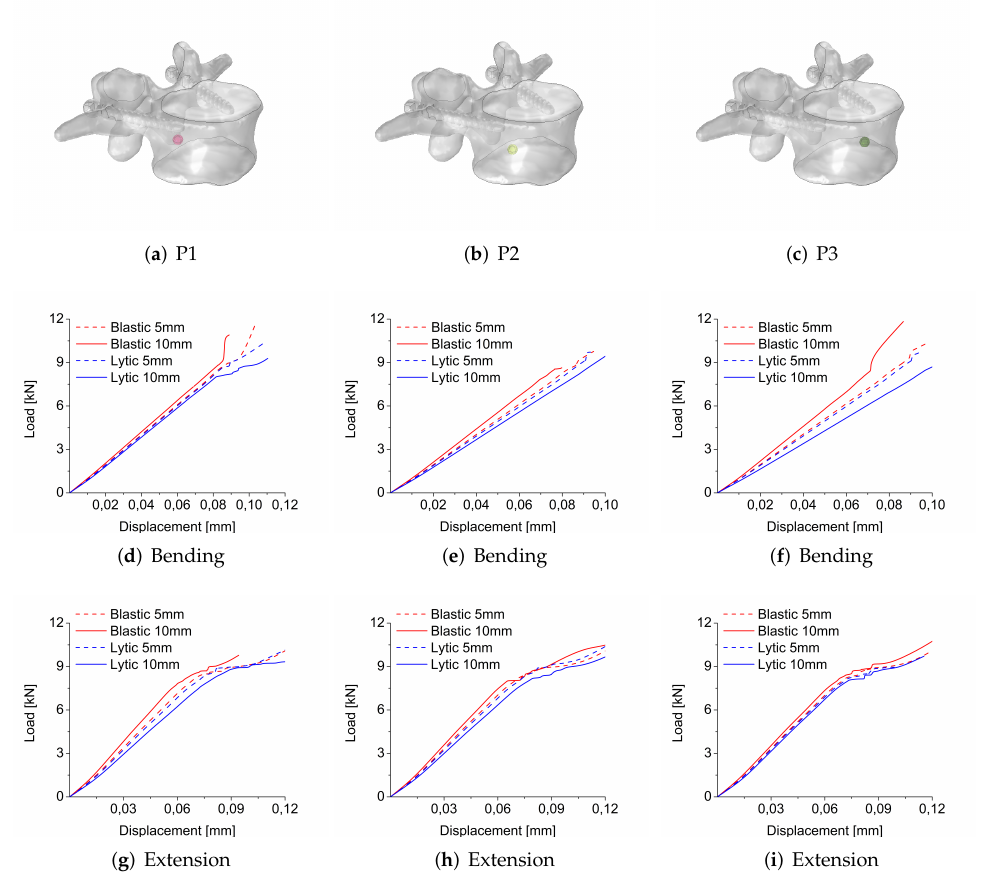
Figure 11. For each position (P1 ( a ); P2 ( b ); P3 ( c )), the load-displacement curves obtained for osteoblastic and osteolytic metastases of 5 and 10 mm of radius in bending ( d – f ) and extension- loading ( g – i ) conditions using the strain-based failure criterion are